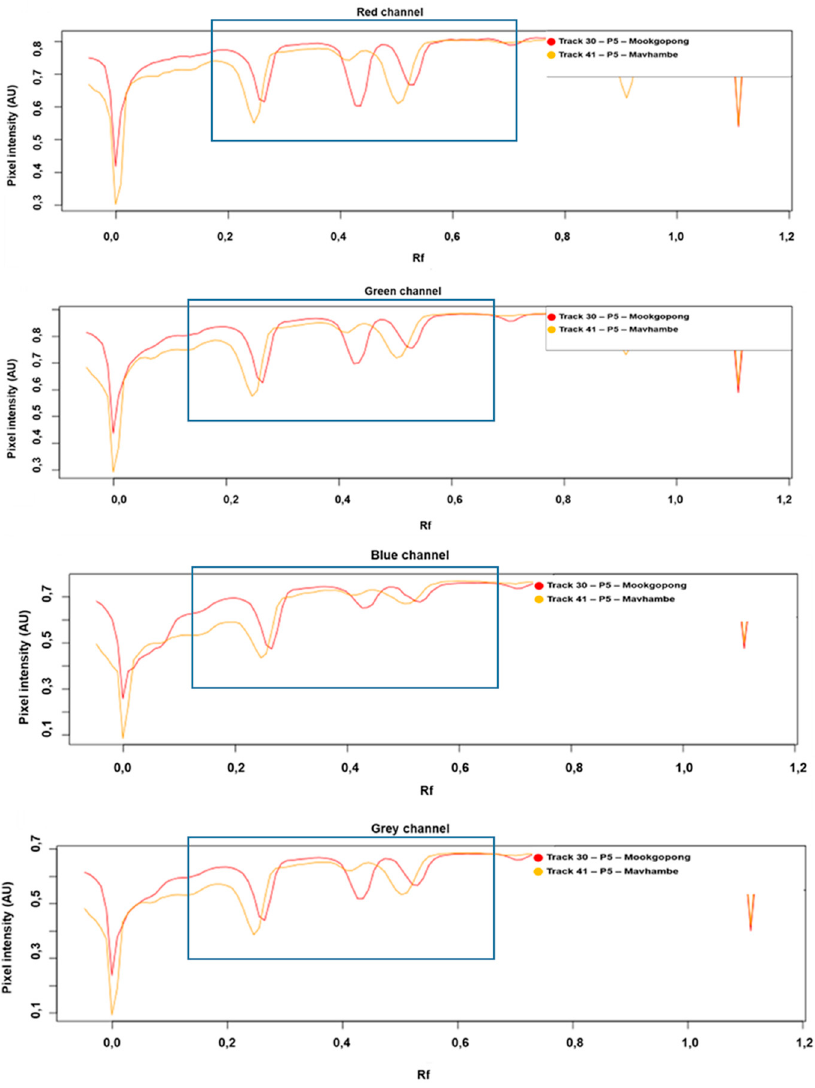
Figure 2. HPTLC tracks and the corresponding rTLC densitograms of T. sericea samples from Mookgophong (Track 30) and Mavhambe (Track 41), depicting different channels and R f ranges that reveal differences between the samples. The blue rectangles indicate the R f range selected for each sample for each channel. These channels and ranges were used as variables to construct the PCA model.